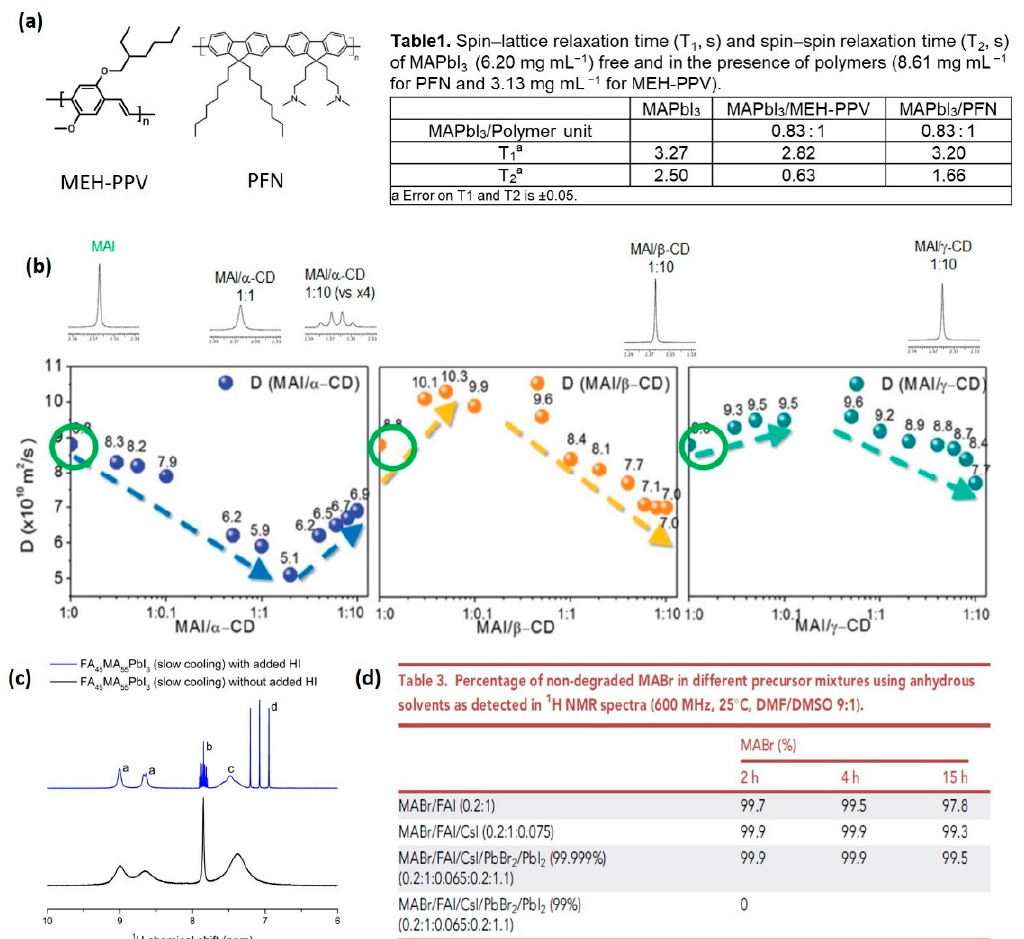
Figure 1. ( a ) Left: chemical structures of MEH-PPV and PFN; right: spin-lattice (T 1 , s) and spin-spin (T 2 , s) relaxation times of MAPbI 3 free and in the presence of PFN and MEH-PPV. Adapted with permission from Sofia Masi et al. 2015. Copyright 2015 Royal Society of Chemistry. [17]. ( b ) Top: expansion of the low-frequency spectral region of 1 H NMR spectra of MAI in mixtures with α -CD, β -CD and γ -CD; bottom: plots showing the variation in the diffusion coefficient (D) of MAI during titration with CDs. Reprinted with permission from ref. [21]. Copyright 2021 Royal Society of Chemistry. ( c ) 1 H NMR spectra of FA 45 MA 55 PbI 3 spiked with HI (top) and without added HI (bottom). ( a ) Protons of the FA amine groups, ( b ) CH of FA, ( c ) NH 3+ of MA, ( d ) NH 4+ . Reprinted with permission from ref. [60]. Copiright 2021 American Chemical Society ( d ) Percentage of non-degraded MABr in different precursor mixtures detected in 1 H NMR spectra. Reprinted with permission from ref. [61]. Copyright 2021 Cell Reports Physical Science.